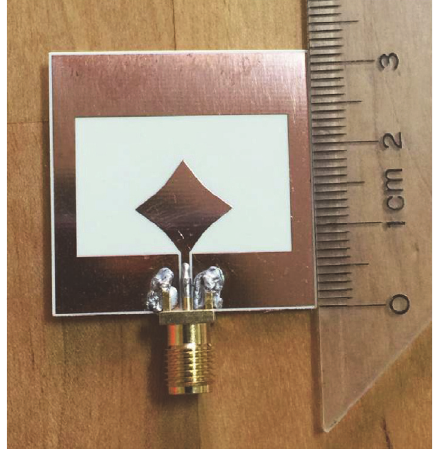
Figure 7: The fabricated antenna